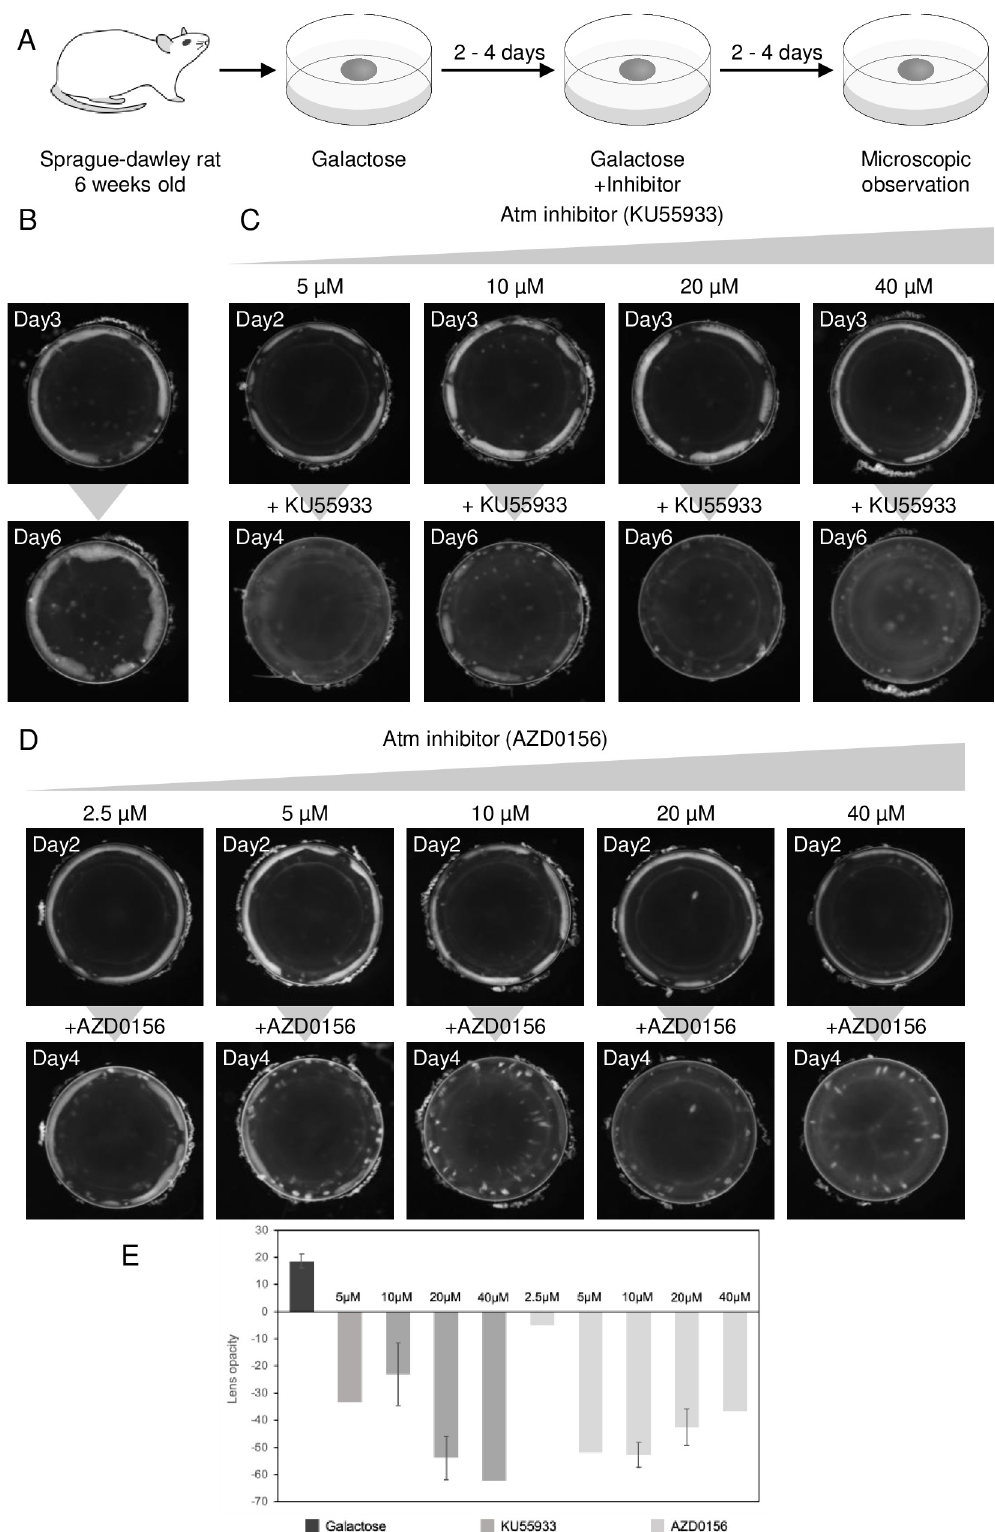
Fig 1. Effect of ATM inhibitors on the reduction of opacity. (A) Experimental scheme. (B) Lenses cultured in medium containing 30 mM galactose for 2–4 days (upper panel). Subsequently, DMSO vehicle control was added, and lenses